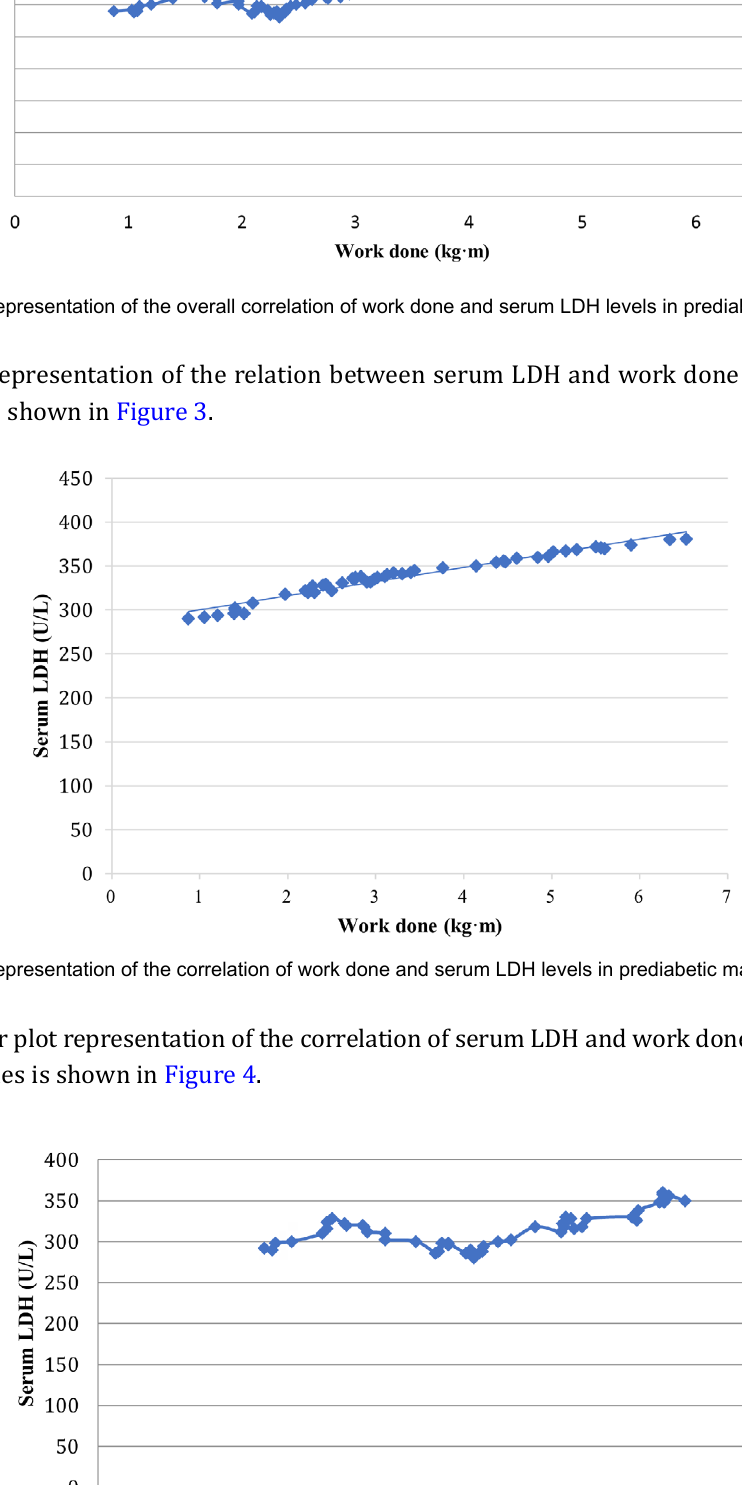
Figure 4. A scatter plot representation of correlation of work done and serum LDH levels in prediabetic females